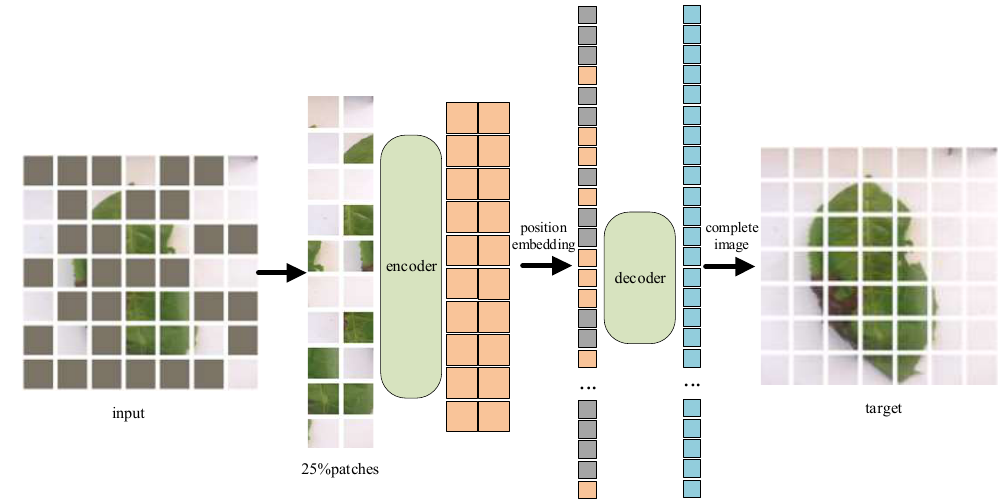
Figure 3. Masked autoencoder ( MAE) structure of tea disease images.